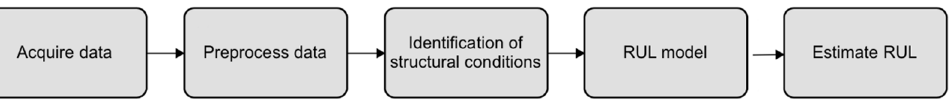
Figure 13. Flowchart for the remaining useful life estimation algorithm.